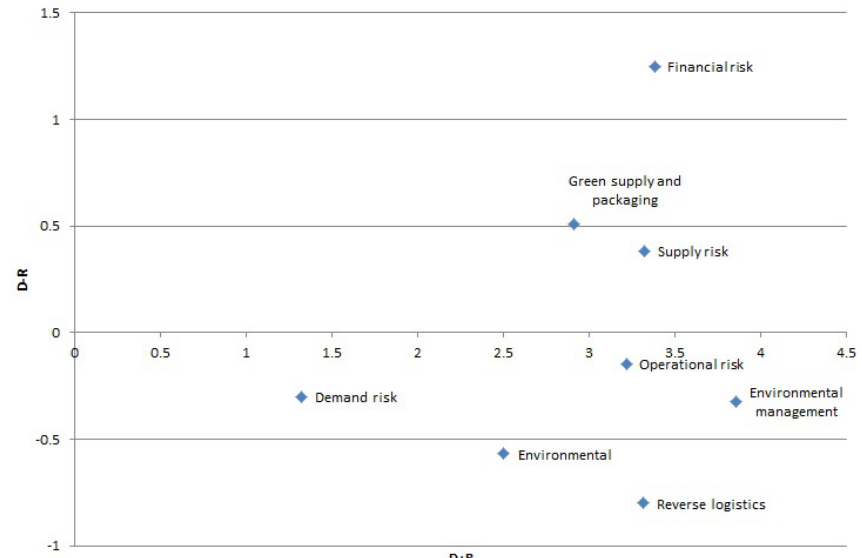
Figure 3. Influence of the key indicators for the greenness and risk of the supply chain, derived from DEMATEL method